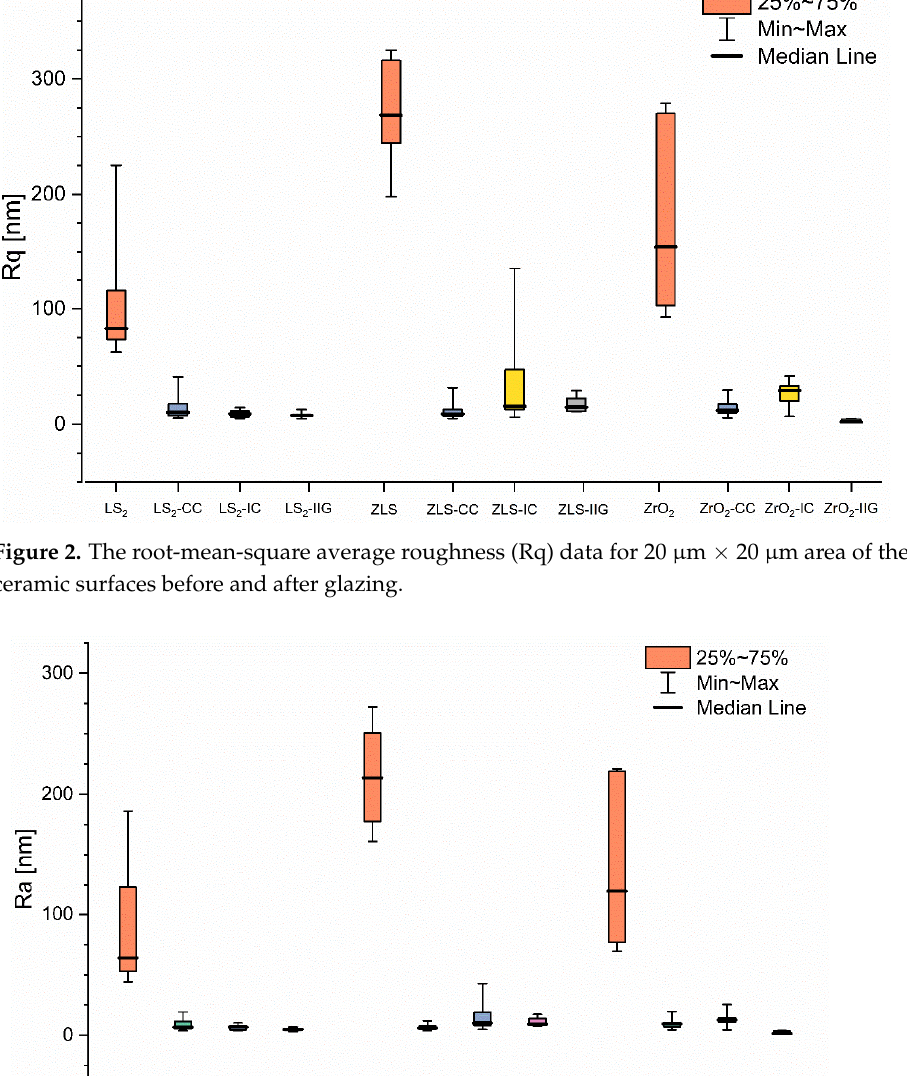
Figure 3. The average roughness (Ra) data for 20 μ m × 20 μ m area of the tested ceramic surfaces before and after glazing.